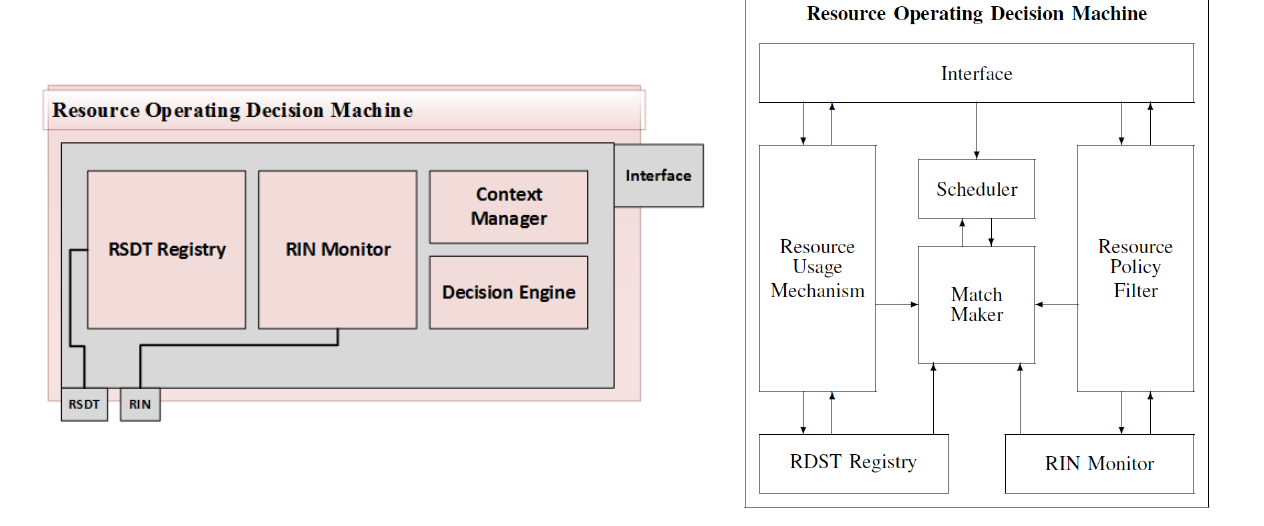
Figure 1. Structure of the resource operating decision machine